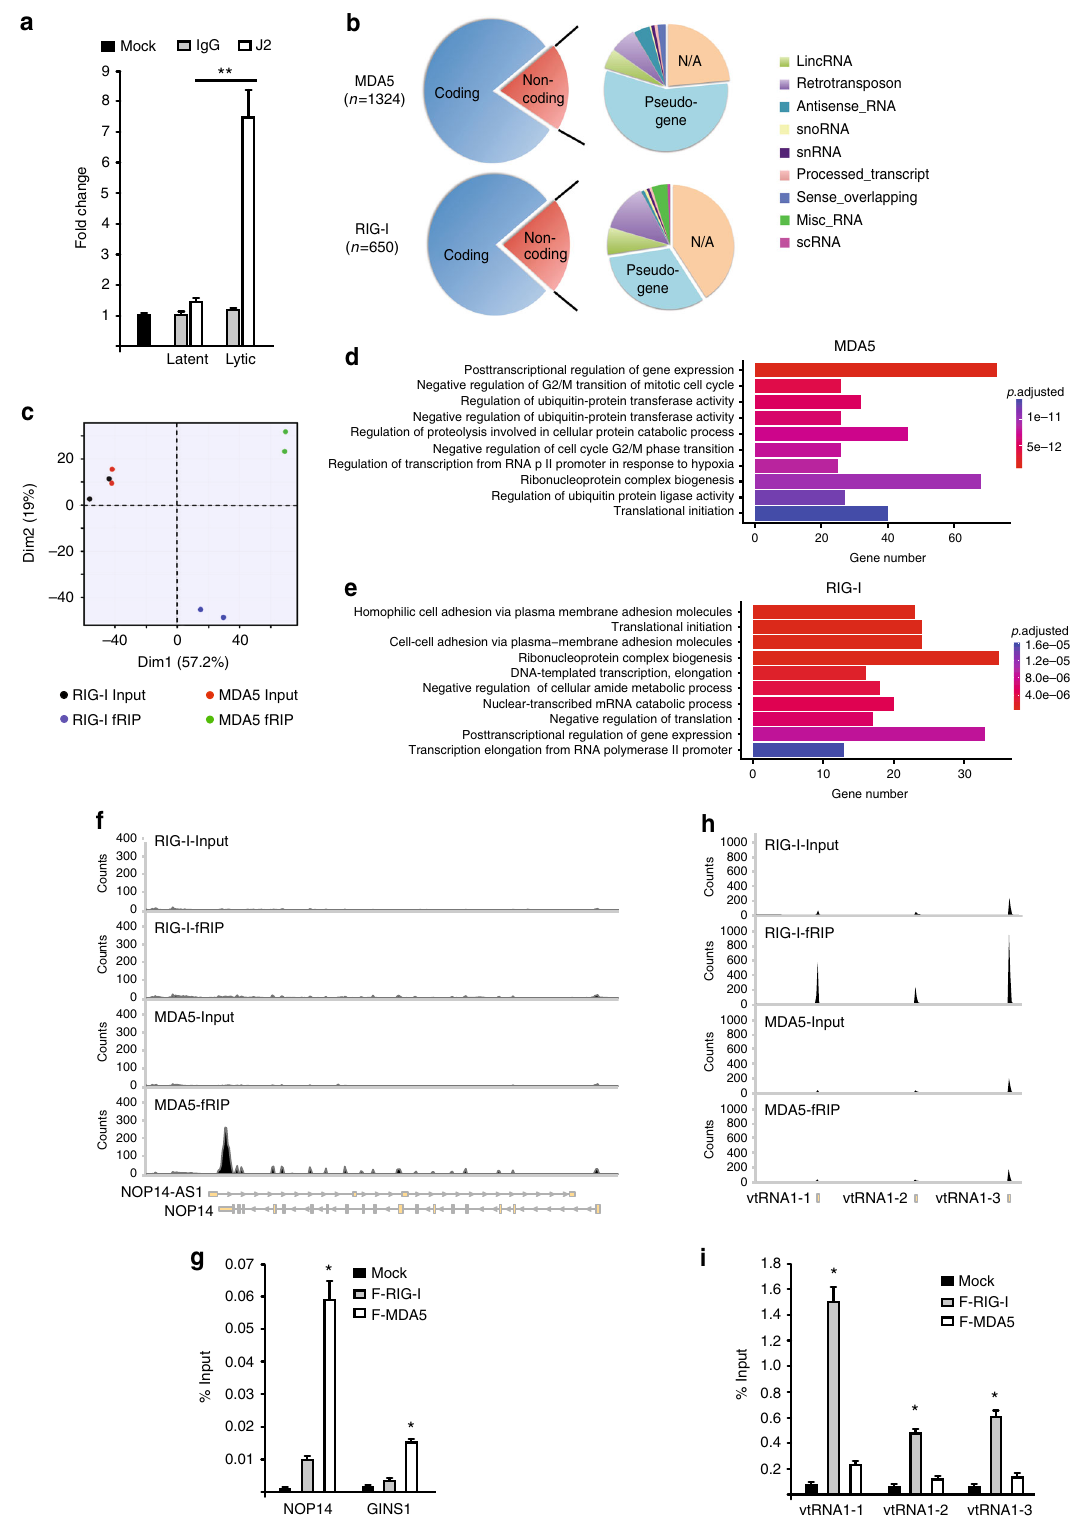
Fig. 4 RIG-I and MDA5 bind host RNAs during lytic reactivation in PEL. a HCT116 dual cells were transfected with RNA puri fi ed from latent and lytic BC-3 cells either by IgG or J2 antibody. Cells were harvested 24 h posttransfection and subjected to luciferase assay. Mock indicates no antibody. b Pie chart representation of gene biotypes identi fi ed by F-RIG-I and F-MDA5 fRIP-seq. c PCA analysis. d , e The gene ontology overrepresentation analysis of enriched RNAs from F-MDA5 ( d ) and F-RIG-I ( e ) fRIP-seq. f Distribution of MDA5 fRIP-seq reads on the NOP14 locus. g fRIP-qPCR analysis of NOP14 and GINS. h Distribution RIG-I fRIP-seq reads at the vtRNA loci. i fRIP-qPCR analysis of vtRNAs. Error bars in all panels represent mean ± SD from three independent experiments. p Values were determined by the Student ’ s t test, * p < 0.05, ** p <